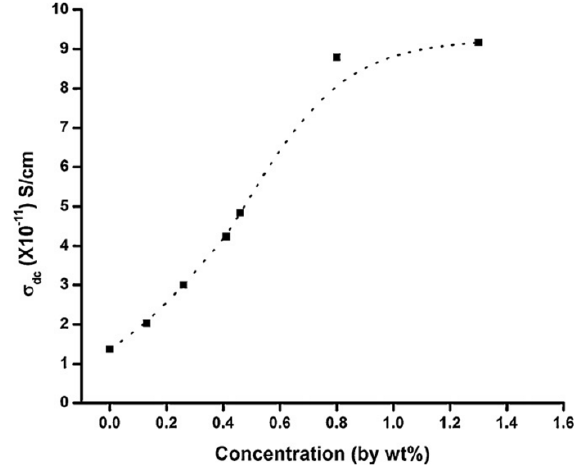
Figure 24. Variation in dc conductivity ( σ dc ) of PVA-Ag nanocomposites with concentration (wt %) of Ag nanoparticles. (Reproduced with permission from [98]) (Copyright Elsevier